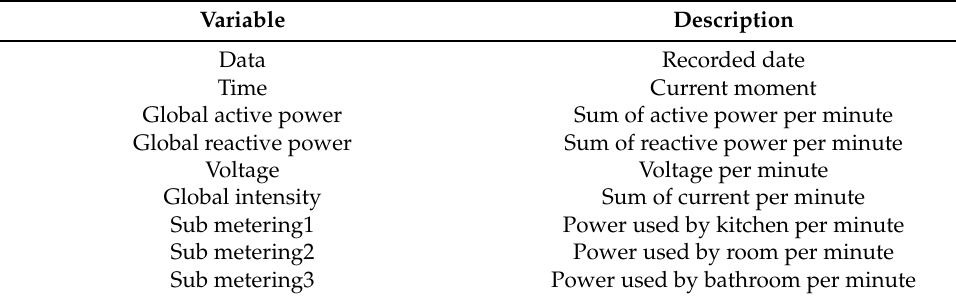
Table 1. Information from the IHEPC